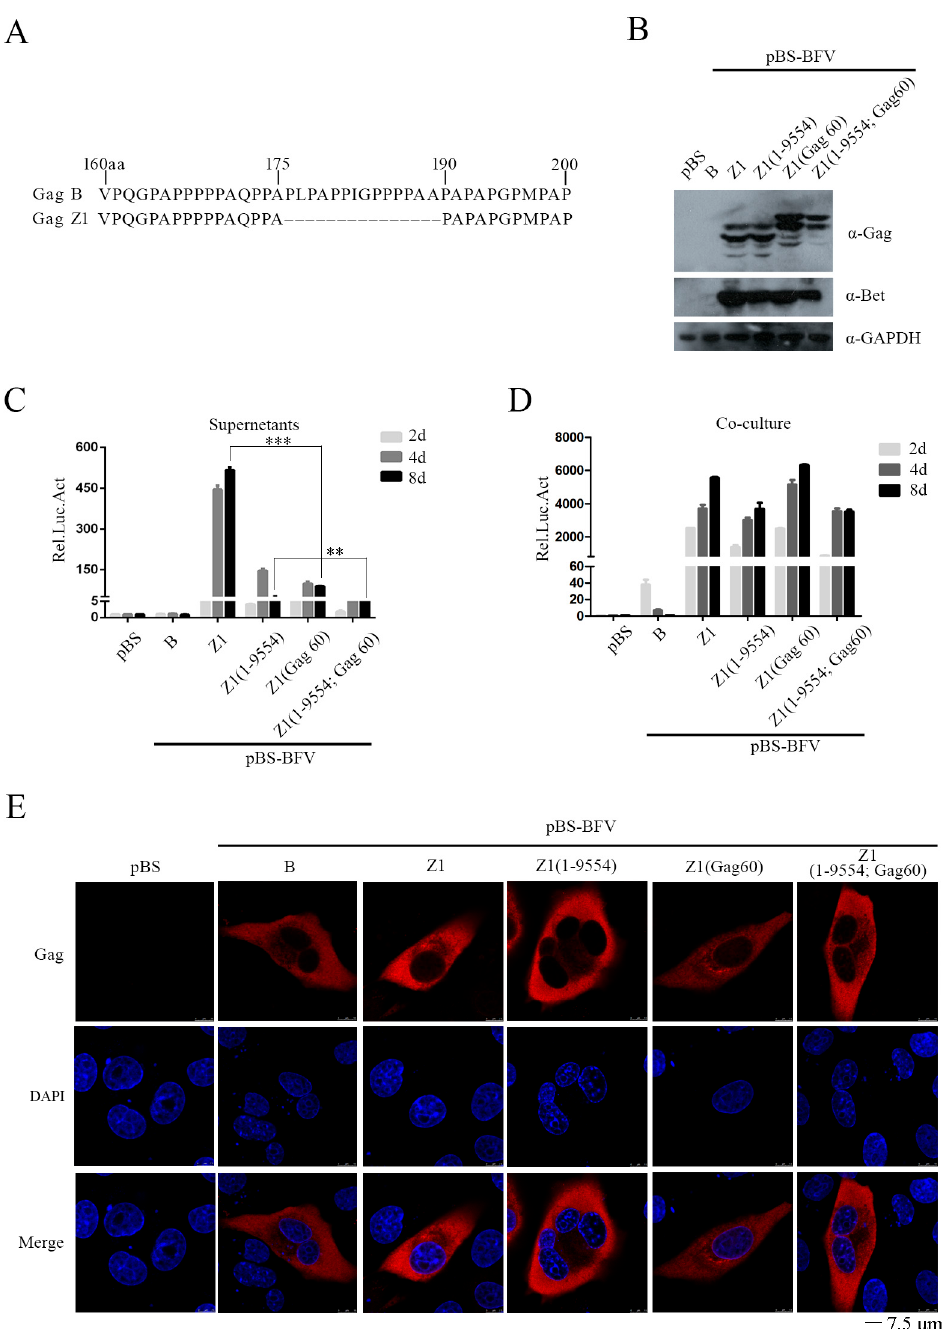
Figure 5. The 14 aa deletion in gag gene increases BFV cell-free transmission activity. ( A ) Partial results—sequence alignment of amino acids in Gag-B and Gag-Z1 is shown in the top left corner. Starting with the 176th amino acid, 14 consecutive amino acids are missing in